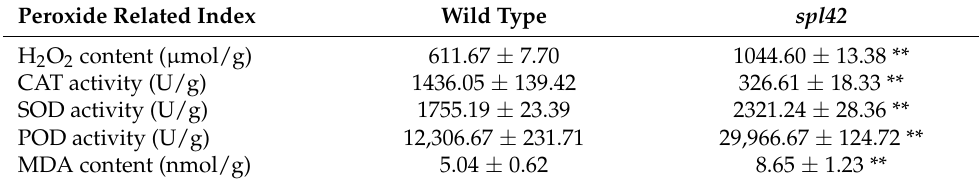
Table A2. Peroxide related index content of wild type and spl42 .